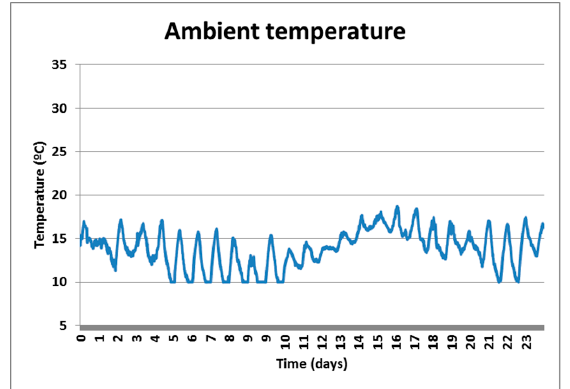
Figure 14. Ambient temperature profile.